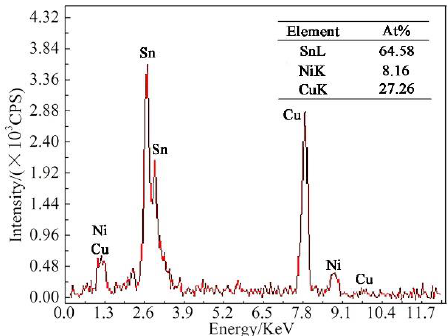
Figure 6. EDS results of the solder joint interface in Figure 5b.